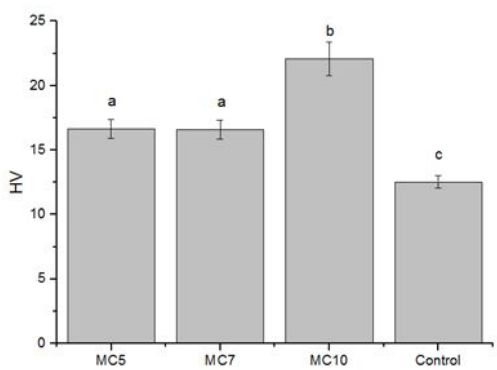
Figure 4. Vickers hardness of the magnetocaloric composites and control sample. Different letters indicate statistical differences between the samples.